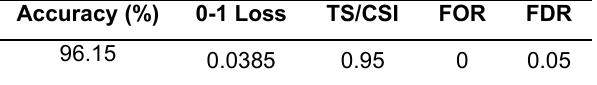
Table 5. Results of